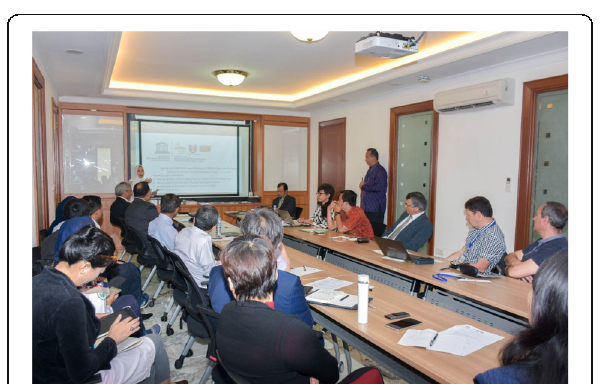
Fig. 8 UNESCO Chair and ICGdR Council Meeting